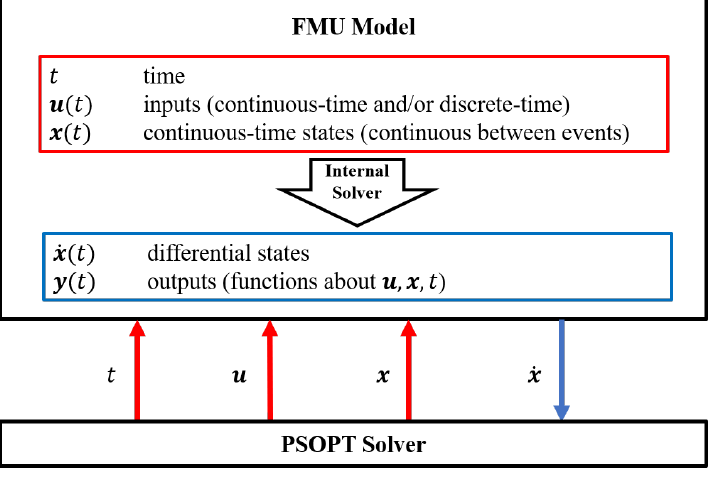
Figure 3. FMU structure